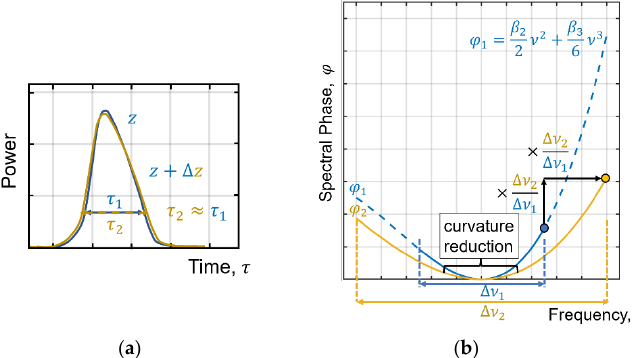
Figure 3. ( a ) Illustration of pulse power versus time of a pulse that undergoes substantial SPM bandwidth broadening while maintaining only a small increase in pulse duration. The power profiles at two positions of propagation are shown, the blue spectrum being at position z , while the yellow profile is when the pulse is at a later position z + ∆ z . ( b ) Illustration sketch of the spectral phase function (irrelevant terms to the analysis are omitted) of the pulse shown in ( a ). The phase spectra at the same two positions of propagation are shown. At the latter location, the phase spectrum is scaled by the ratio of bandwidths in the directions of the arrows. The dotted blue curve shows the extension of the spectral phase function for the pulse at z over the bandwidth range of the pulse at z + ∆ z to highlight the relative flattening of the phase.